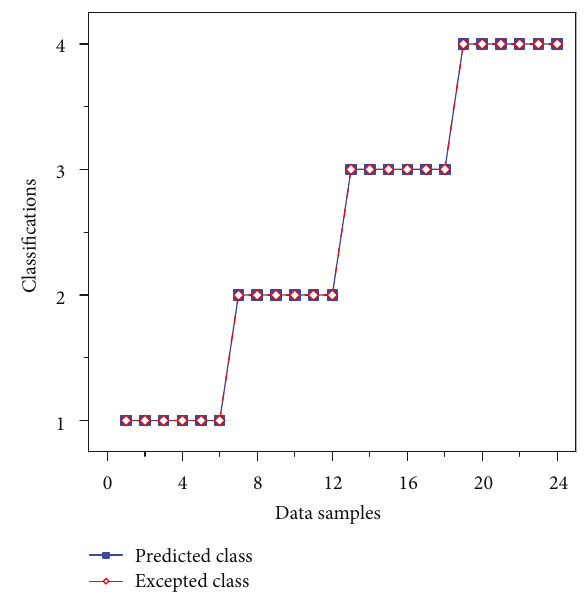
Figure 12: The distribution of winning nodes at the competitive layer.